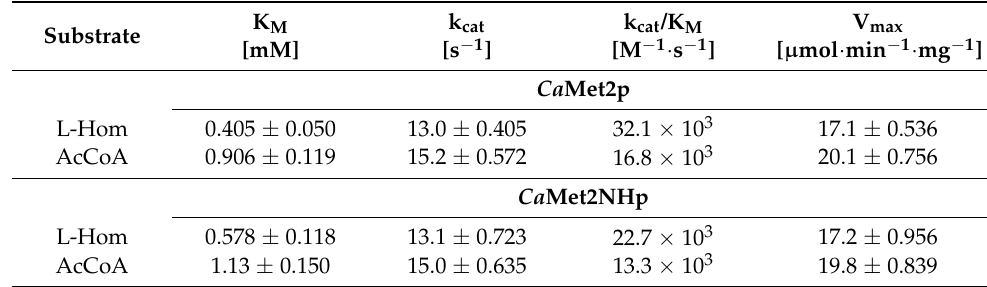
Table 1. Kinetic parameters of C. albicans Met2p and Met2NHp. Value of k cat were calculated per monomer. Data shown are the means of at least three independent experiments ± SD.